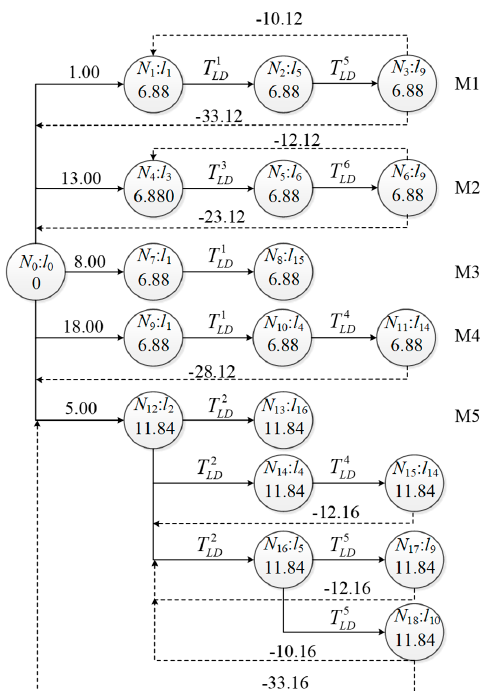
Figure 2. Directed graph of task scheduling chart based on temporal constraints .